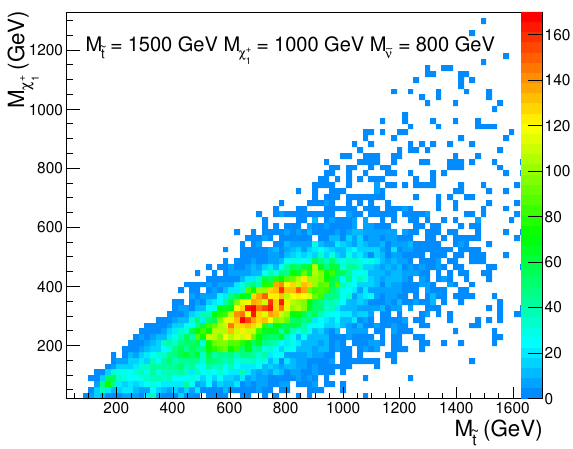
Figure 10 . Reconstructed signal distributions for stop pair production with M ˜t = 1500 GeV, M = 1000 GeV, M ˜ ν = 800 GeV together with the expected background processes corresponding x + 1 to an intergrated luminosity of 50 fb − 1 at 13